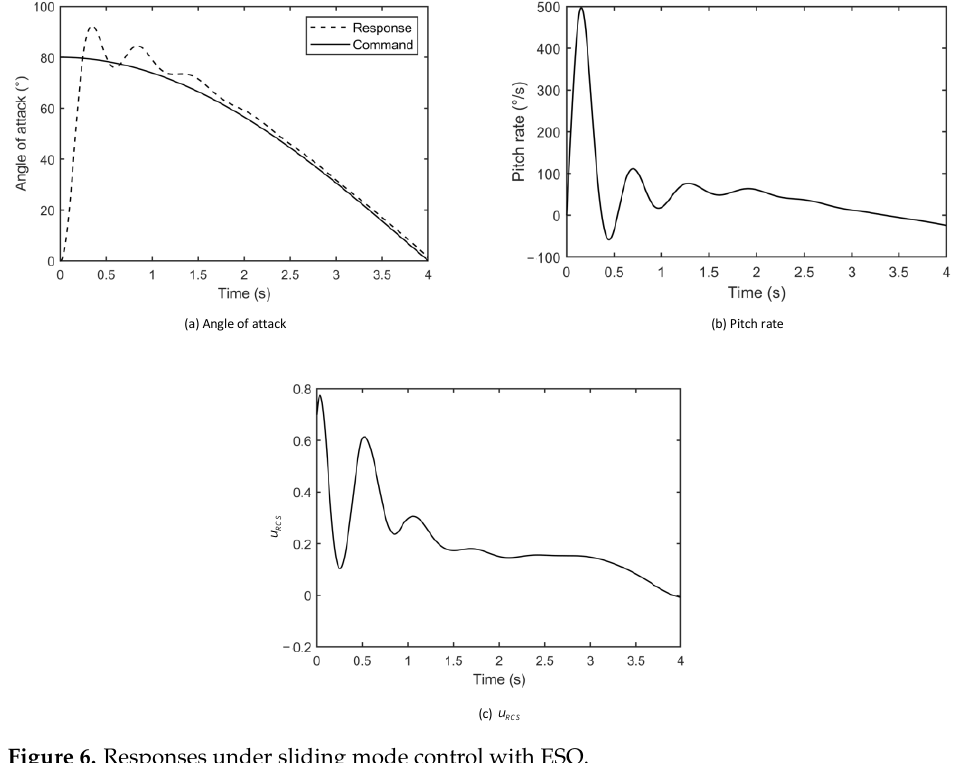
Figure 5. Responses under traditional I&I method.